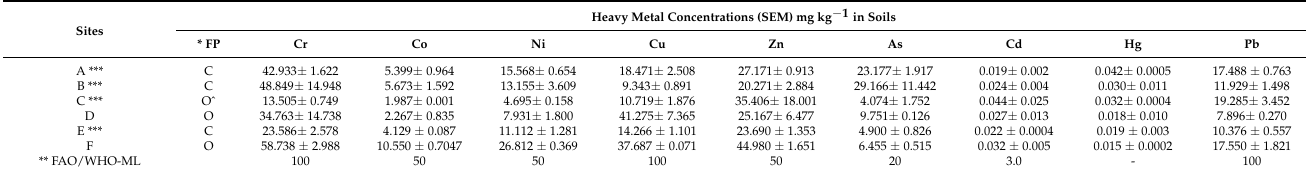
Table 3. Average concentrations of selected heavy metals in soil samples from different sites collected in summer and winter.